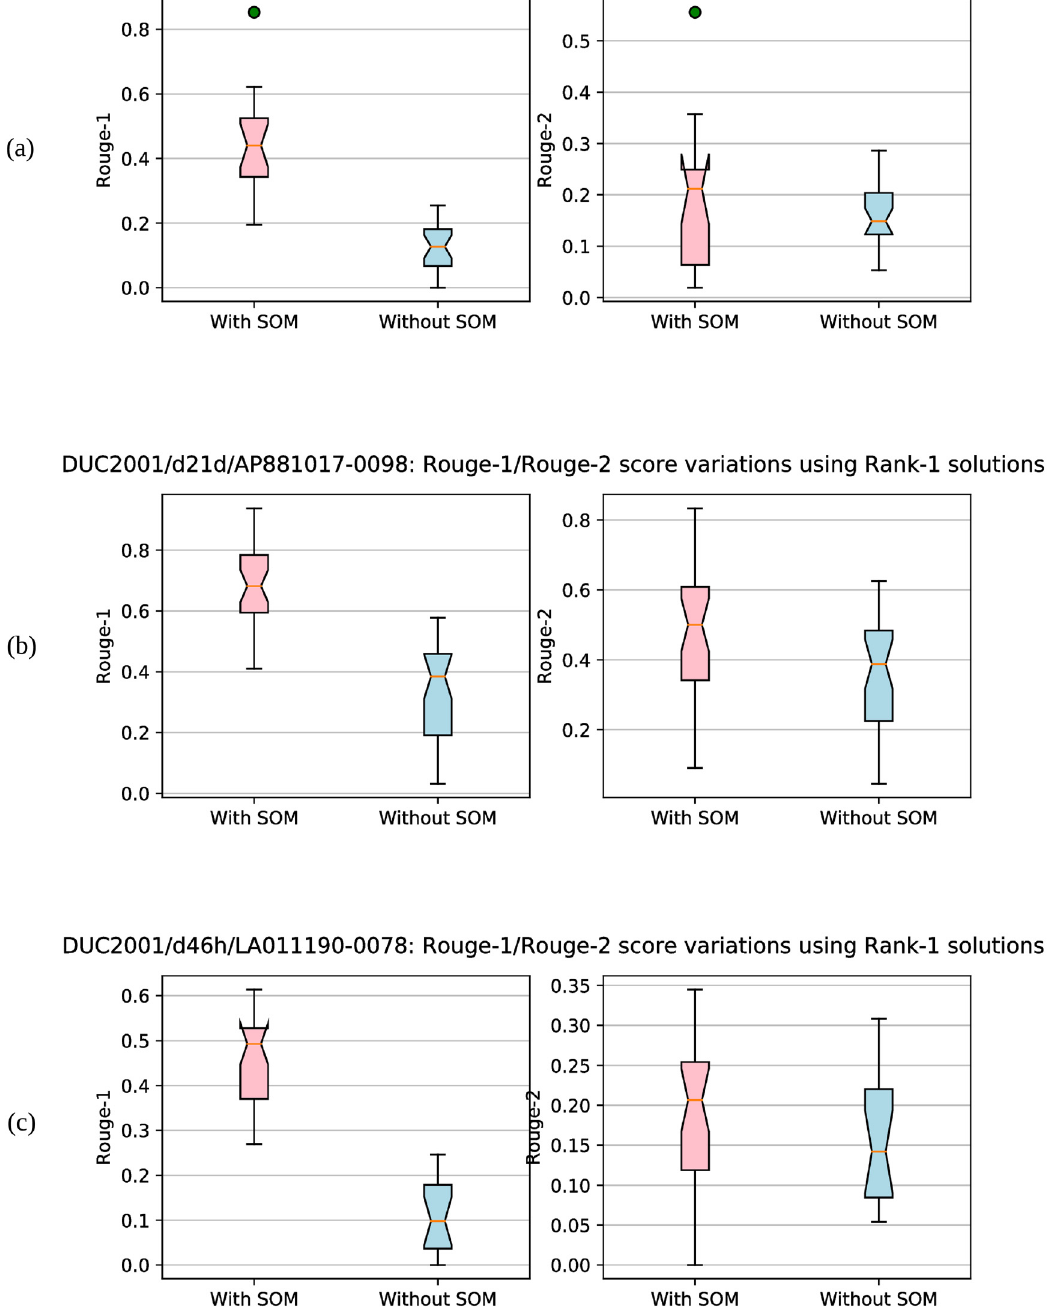
Fig 8. Box plots. Sub-figures (a), (b) and (c) show the Rouge-1/Rouge-2 score variations per document over DUC2001 dataset. In each colored box, the horizontal colored line indicates the median value of Rouge-1/Rouge-2 score using rank-1 solutions of a